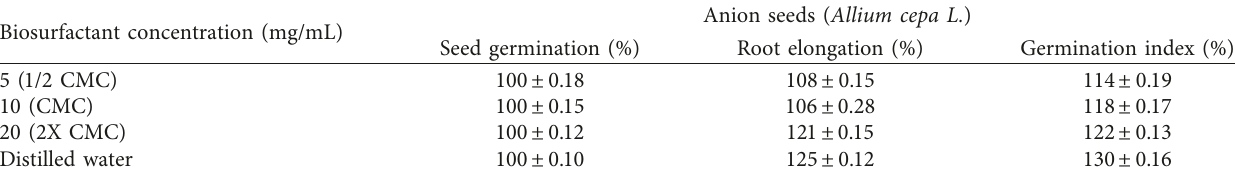
Table 4: Phytotoxicity evaluation of the biosurfactant produced by C. echinulata . Biosurfactant concentration (mg/mL)